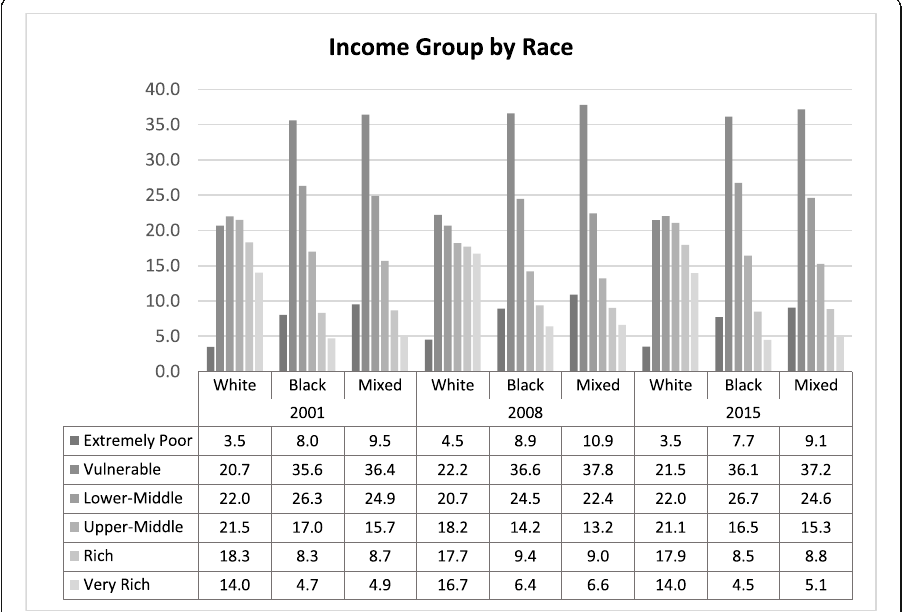
Fig. 3 Income group by race. Data source: National Household Sample Survey, 2001, 2008, and 2015 —